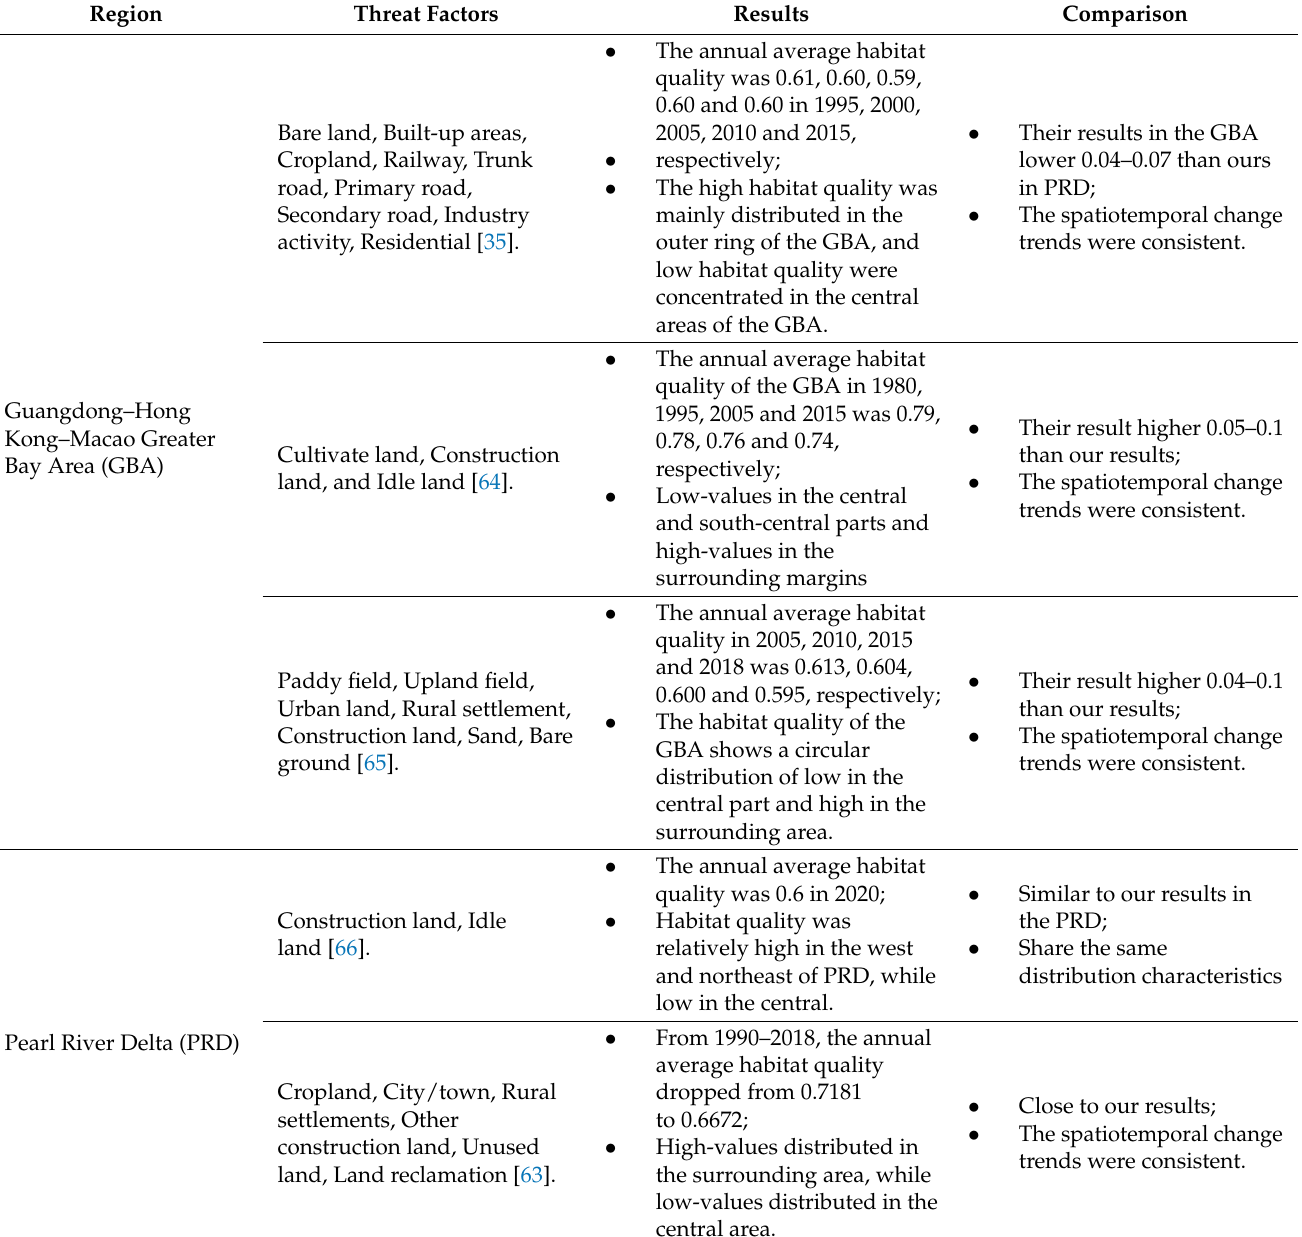
Table 6. The assessment results of habitat quality within Guangdong Province of other scholars. Region Threat Factors Results